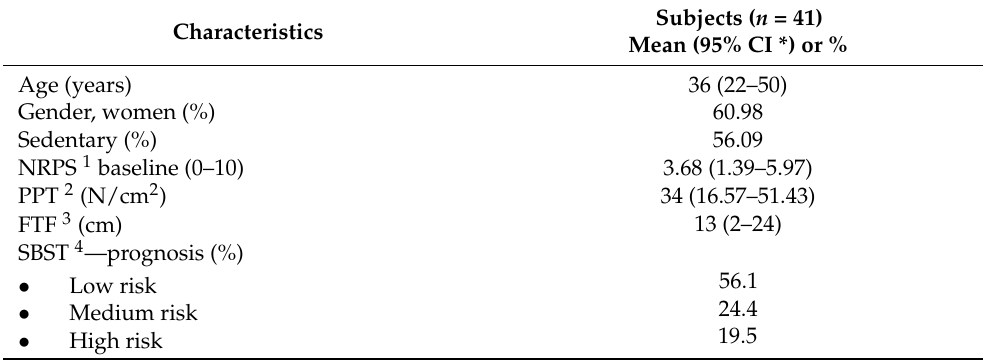
Table 1. Characteristics of the participants at